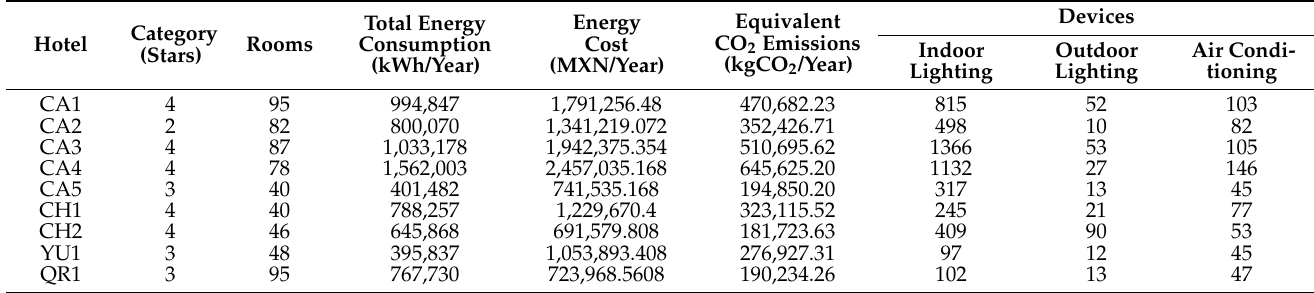
Table 2. Information collected during energy audits of hotels in the Mexican southeast.